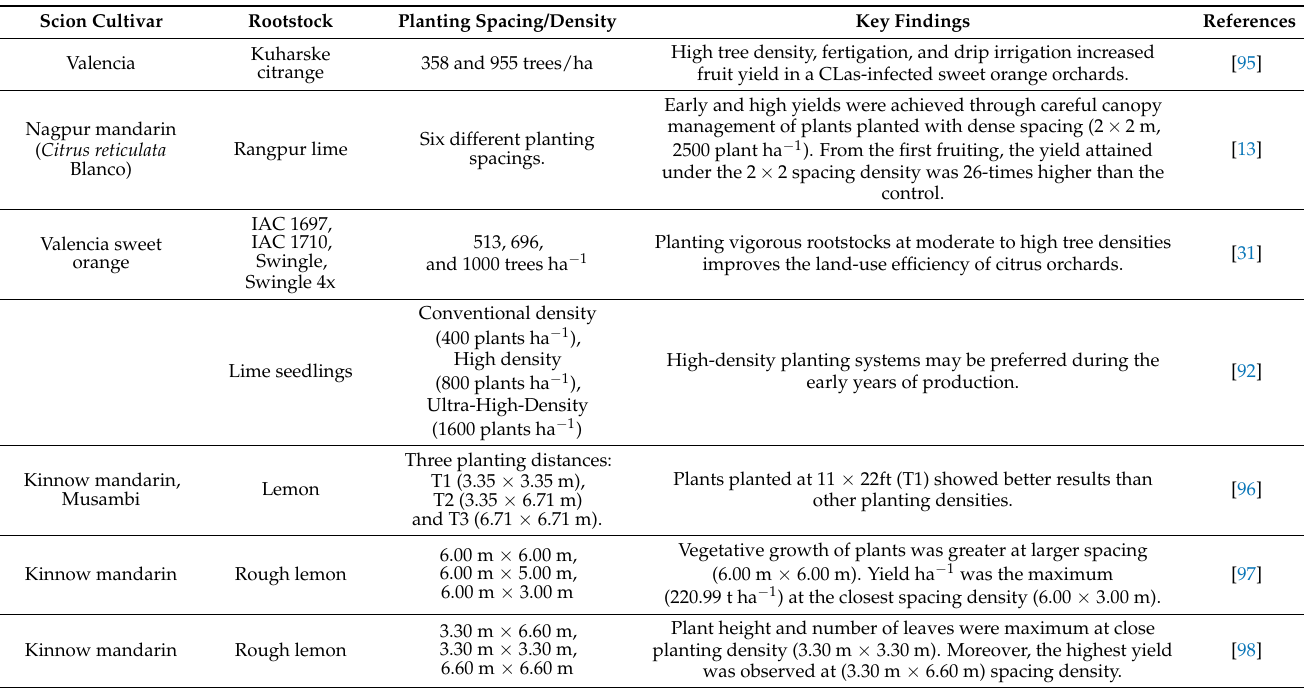
Table 5. Effects of planting density on plant growth and fruit